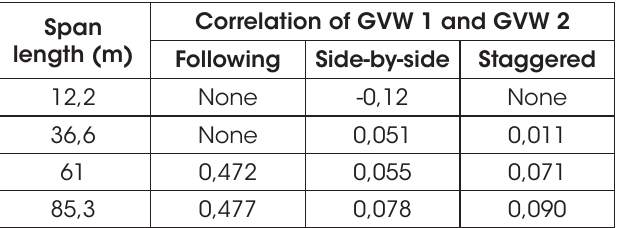
Correlation between GVWs for each case of multiple